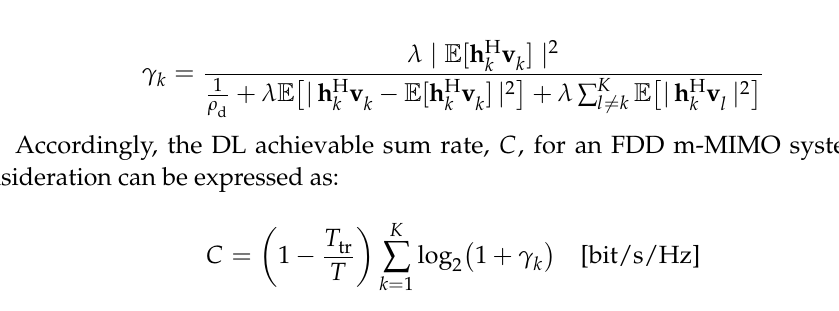
Figure 1. A base station with N m-MIMO that serves K users in FDD